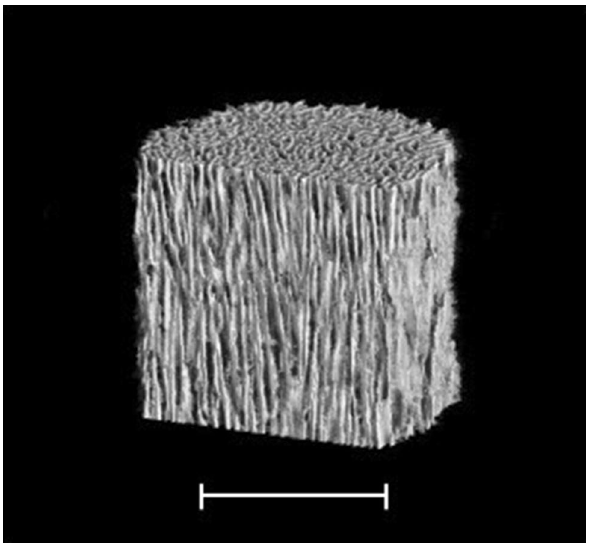
Figure 1. Three-dimensional micro-CT image of UDPHAp (provided by Kuraray Co., Ltd.), showing the unidirectional pores in the vertical direction and some interconnection toward the horizontal direction. Bar; 1000